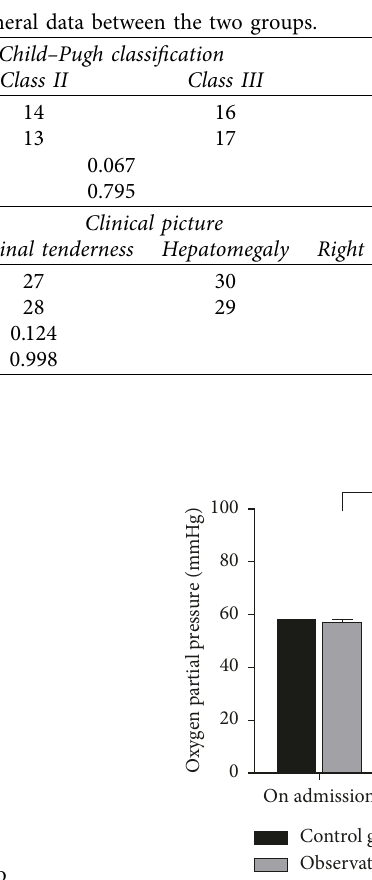
Figure 3: Comparison of oxygen partial pressure between the two groups. Note: compared with the control group,